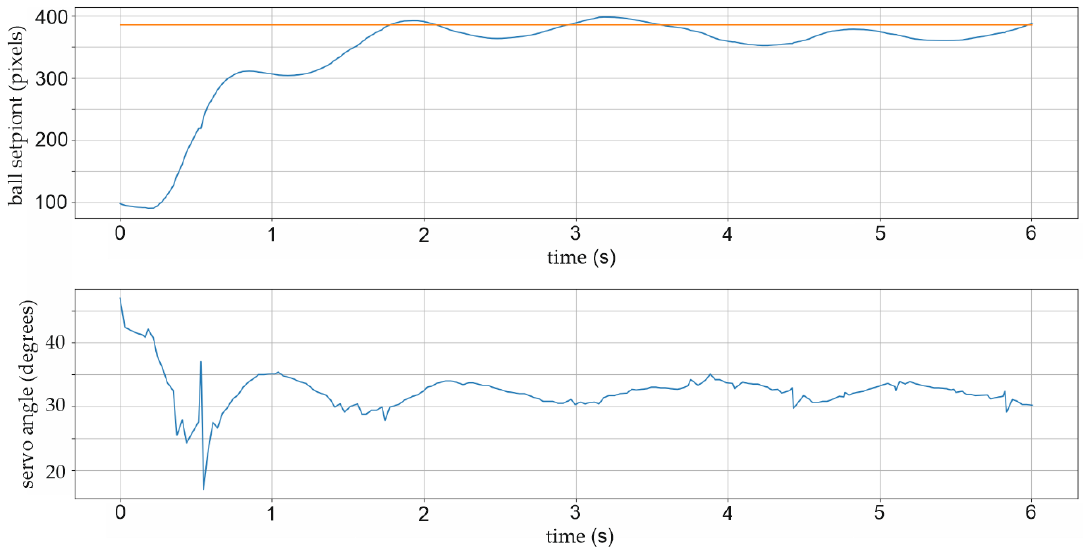
Figure 16. Experiment result: BPS printed bottom plate and upper Plexiglas smooth plate.